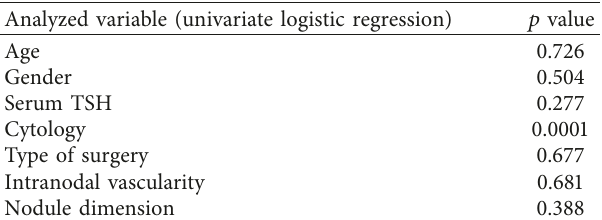
Table 5: Univariate logistic regression: analyzed variables and their respective p